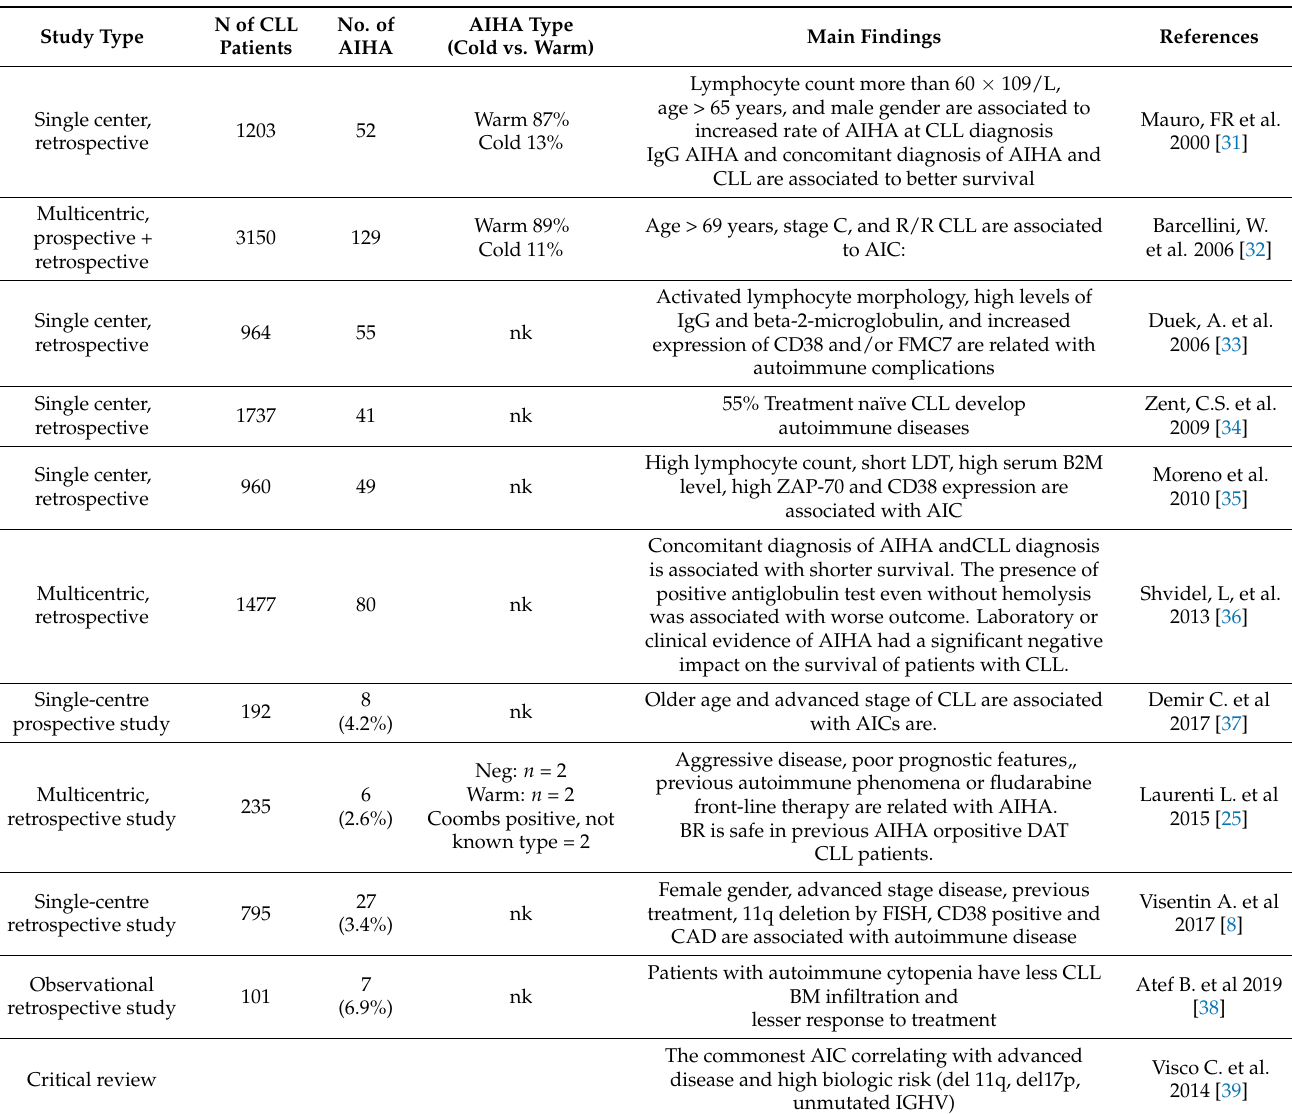
Table 1. Major published experiences on AIHA in